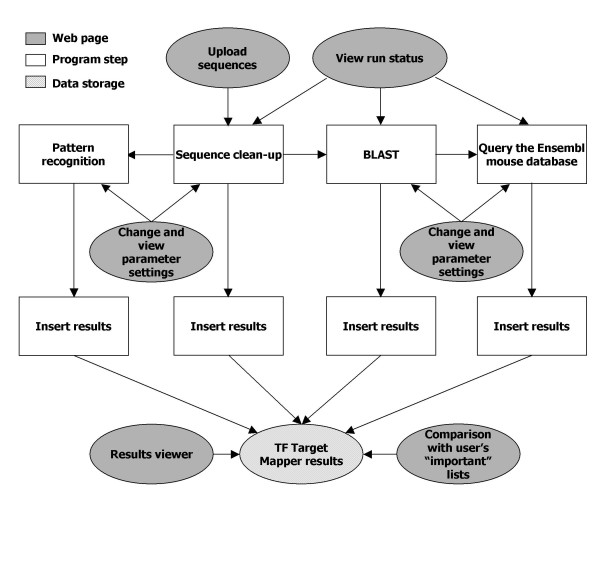
TF Target Mapper application flowchart :  Simplified flowchart of the TF Target Mapper application, summarizing its basic functions.